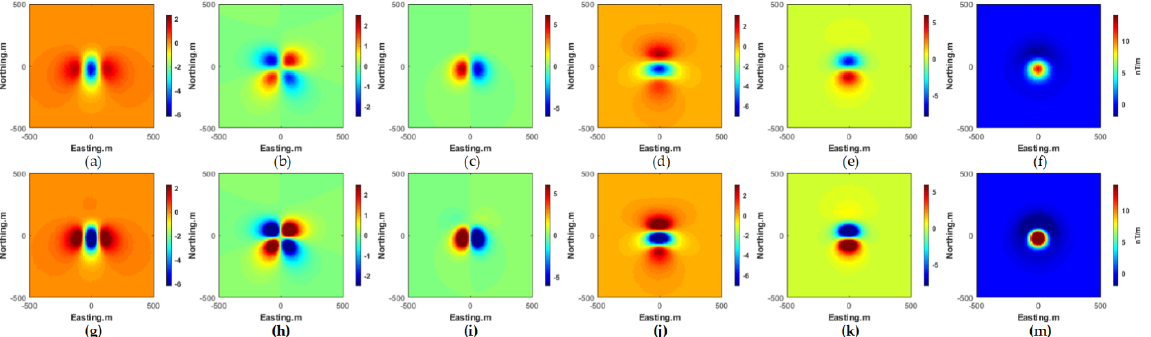
Figure 10. Comparison of inversion results. ( a ) Input model: Rectangle_2B; ( b ) and B zz inversion result.